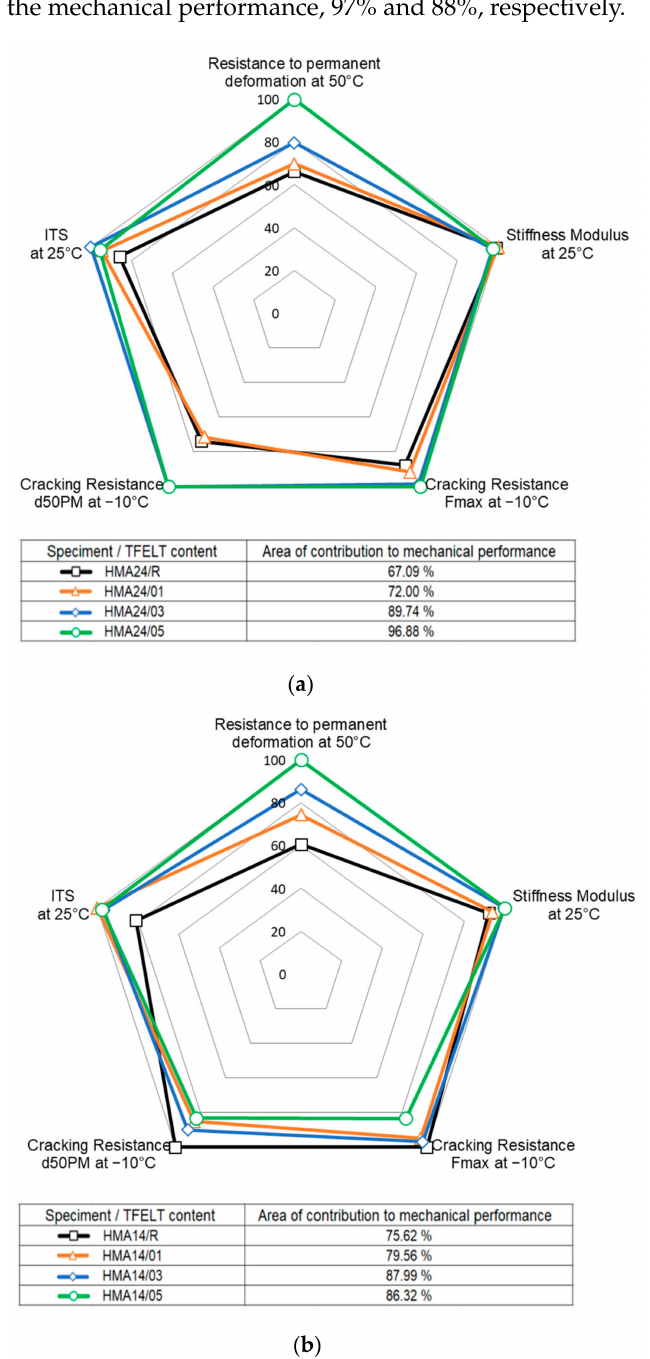
Figure 12. Radar graphs for the contribution to mechanical performance of the HMA mixes manufac- tured with AB-PFELT: ( a ) HMA24; ( b )